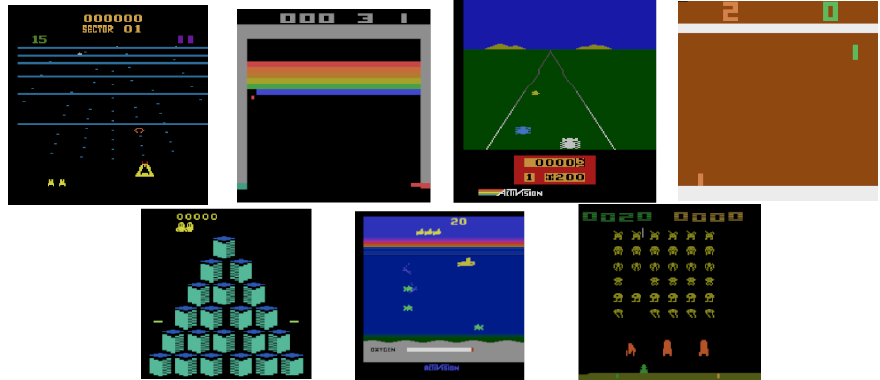
Figure 6. The first games trained by DeepMind Technologies. From the left to right, top to bottom: Beam Rider, Breakout, Enduro, Pong, Q ∗ bert, Seaquest, and Space Invaders. All images taken using the OpenAI Gym Python package [47].